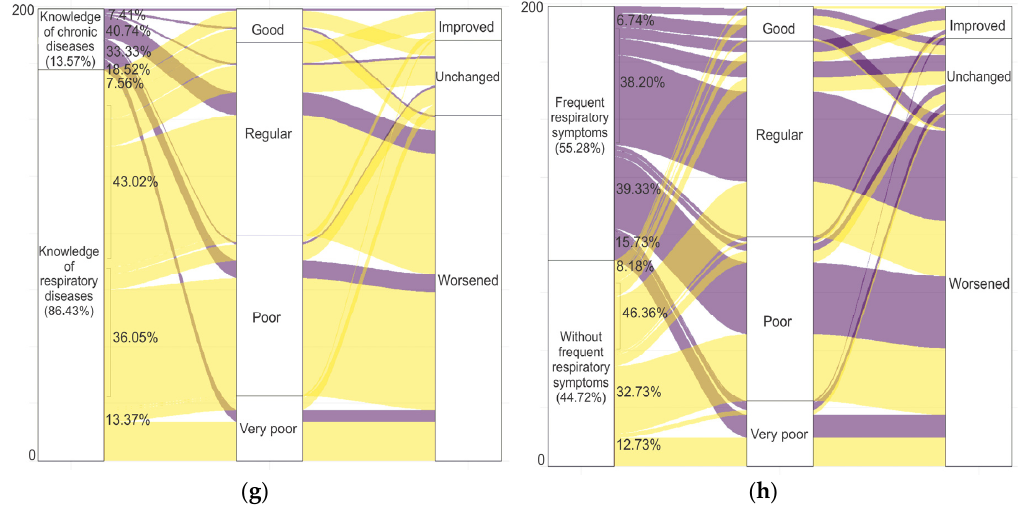
Figure 5. Distribution of perceived air quality at the local level and the perceived changes in the air quality over time by ( a ) age range; ( b ) sex; ( c ) education level; ( d ) average monthly household income (2019 USD); ( e ) sources to check air quality; ( f ) the presence of frequent respiratory symptoms in at least one household member; ( g ) knowledge of the diseases related to air pollution (respiratory or other such as chronic diseases, cancer, neurological and metabolic diseases); and ( h ) the type of pollution sources perceived as more polluting. The colors are related to the number of categories in the first column of each figure. The numbers located next to the first column correspond to the associated percentages of air quality perception at the local level within each category of the first column.